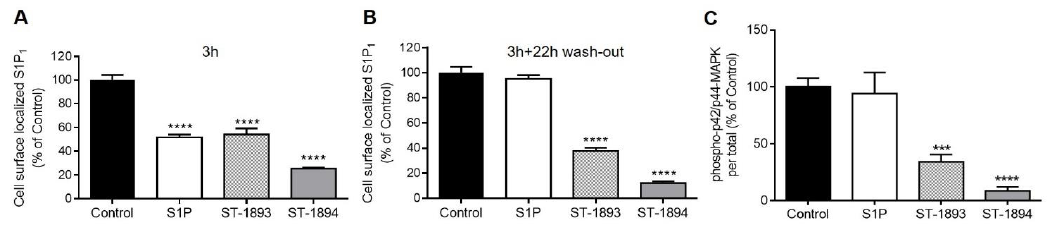
Figure 4. Effect of ST-1893 and ST-1894 on S1P 1 receptor internalization and sustained S1P 1 signaling desensitization. ( A , B ) Starved confluent CHO-K1 cells overexpressing N-Myc-tagged S1P 1 receptor in 24-well plates were stimulated with equimolar concentrations (3 µM) of S1P, ST-1893, ST-1894, or DMSO control for 3 h ( A ), or 3 h followed by 22 h in serum-free conditions for recovery ( B ). Cells were fixed and further processed as explained in Section 4. Results are expressed as a percentage of control and are means ± SD ( n = 3); **** p < 0.0001 compared to DMSO-treated control samples. ( C ) Starved confluent CHO-S1P 1 cells were stimulated with 3 μM S1P, ST-1893, ST-1894, or DMSO (control) for 3 h followed by 22 h washout in serum-free conditions, and a re-stimulation for 10 min with 3 μM S1P. Cell lysates were subjected to Western blot analysis and membranes were probed with phospho- and total p42 / p44-MAPK antibodies. Results are expressed as a percentage of control cells and are depicted as means ± SD ( n = 3); *** p < 0.001, **** p <